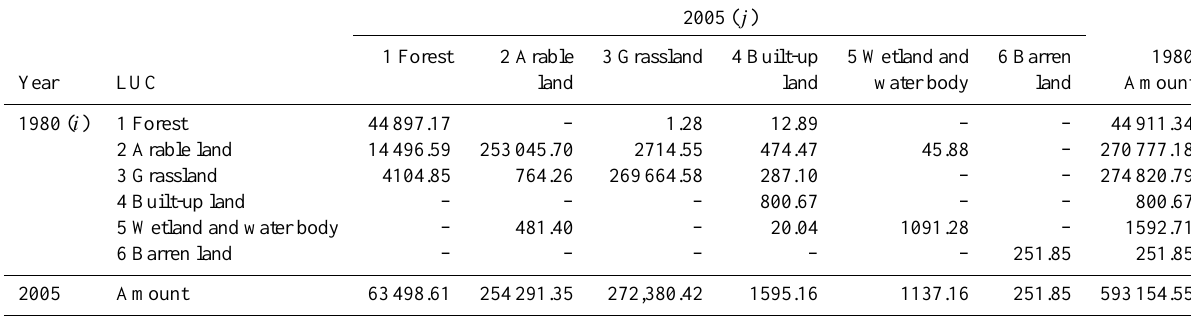
Fig. 5. LUC of the Yan River basin from 1980 and 2005. 2 Table 5. LUC change matrix of upstream area of GHS from 1980 to 2005 (in